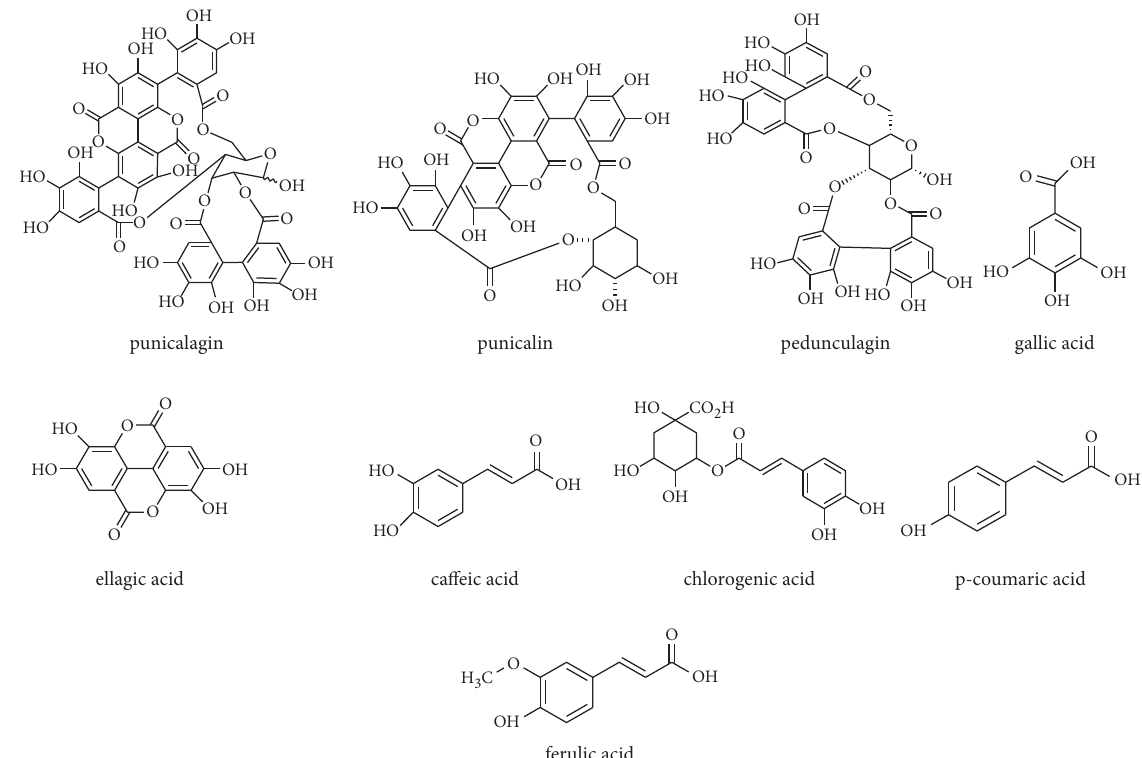
Figure 1: The main phenolic compounds in